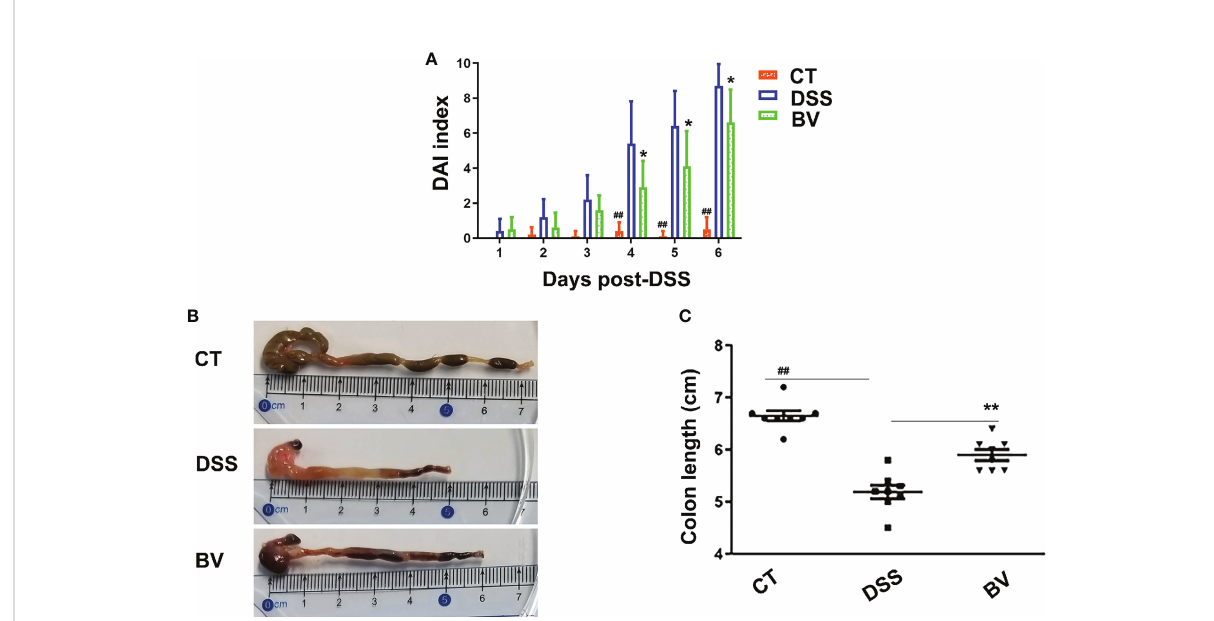
FIGURE 1 Effect of B. vulgatus Bv46 on the DSS-induced colitis in C57BL/6J mice. Disease activity index (DAI) scores (A) and colon length (B, C) of the DSS-induced mice treated with B. vulgatus Bv46 (in the BV group), or phosphate buffer saline (in the DSS group), and control (CT, no DSS induction) for 7 days. Values represent the mean ± standard deviation. *, P < 0.05 and **, P < 0.01 indicated the signi fi cant differences of the DSS versus BV group; ## , P < 0.01 indicated the signi fi cant differences of the DSS versus control